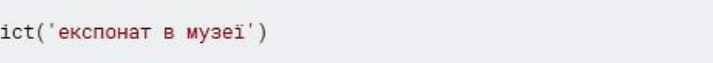
Figure 11. Neural network fails to understand the task.